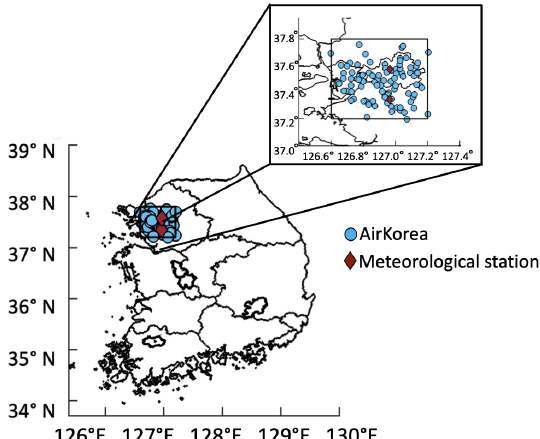
Figure 3. AirKorea monitoring sites in the Seoul metropolitan area (SMA) with hourly ozone and NO 2 concentration data for 2015– 2019. Red diamonds show the two meteorological sites in the SMA operated by the Korea Meteorological Administration (https://data.